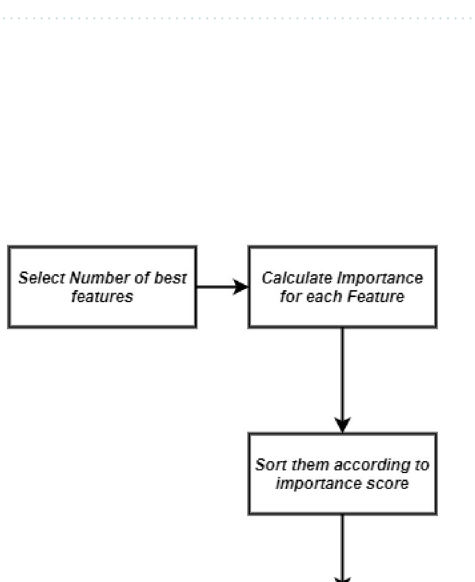
Figure 5. Procedure of recursive feature elimination (RFE).